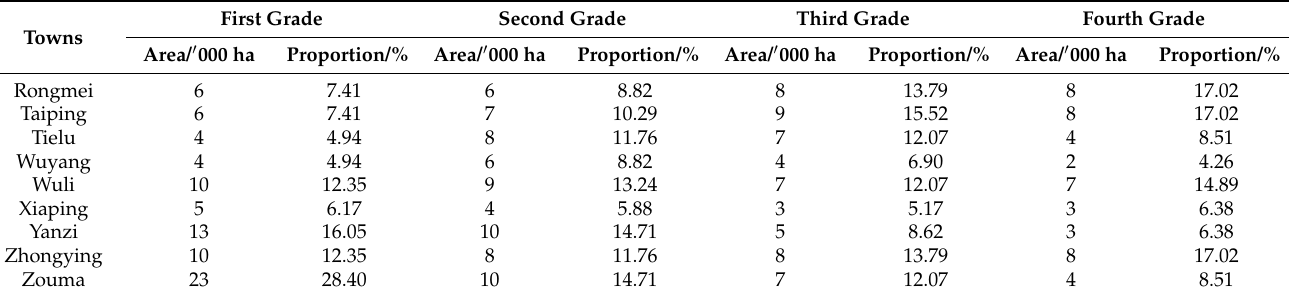
Table 3. Area statistics of forest land quality grades in